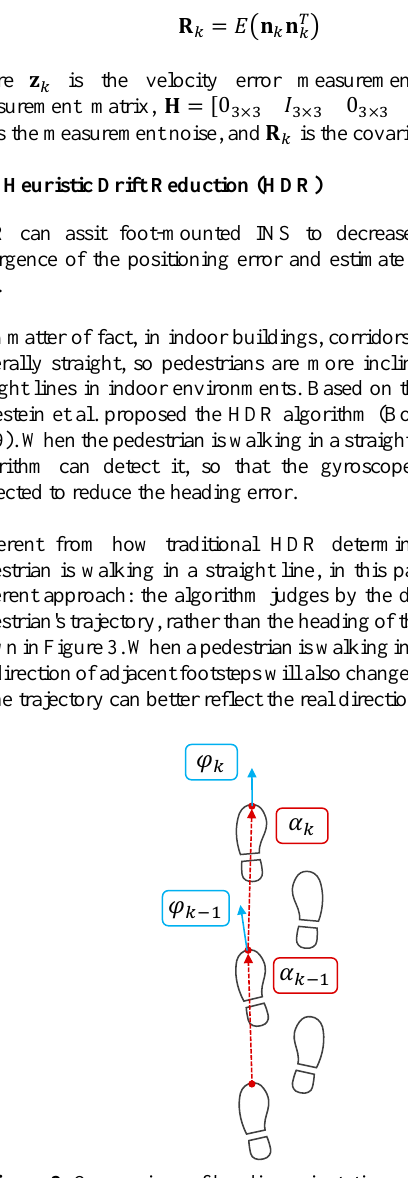
Figure 2 . Main blocks in the zero-velocity detection.